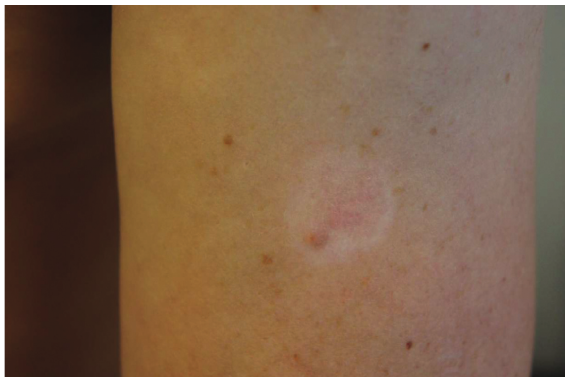
Figure 1: Halo nevus on the left upper arm. The central part shows only a light shadow while the rest of the lesion is depigmented.